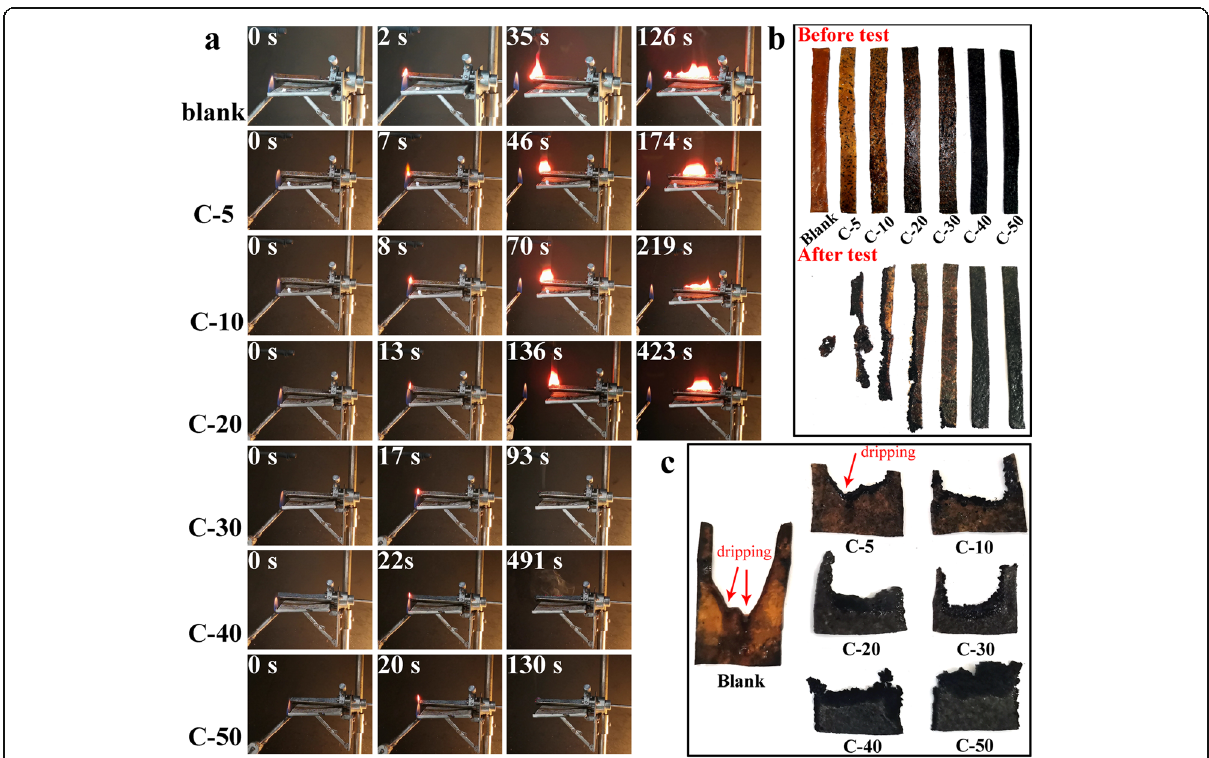
Fig. 1 a snapshots of NR and the CF/NR composites with different CF dosage during the UL94 horizontal burning test. b photos of NR and the CF/NR composites with different CF dosage before and after the UL94 horizontal burning test. c photos of NR and the CF/NR composites with different CF dosage after the LOI